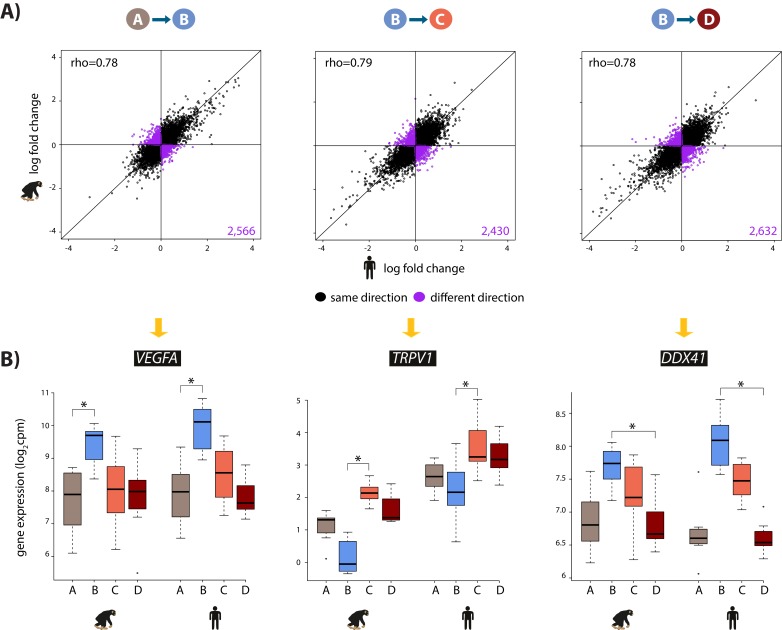
The hypoxic gene expression response is highly correlated across species.(A) The log fold change in expression of 11,974 genes between pairs of conditions in humans on the x-axis, and chimpanzees on the y-axis. Genes whose expression changes in the same direction in both species are represented in black, and genes whose expression change direction differs across species are represented in purple. (B) Examples of genes that are differentially expressed in both species in A vs. B (VEGFA), B vs. C (TRPV1), and B vs. D (DDX41) are shown. Asterisk denotes a statistically significant difference in expression between conditions (10% FDR).